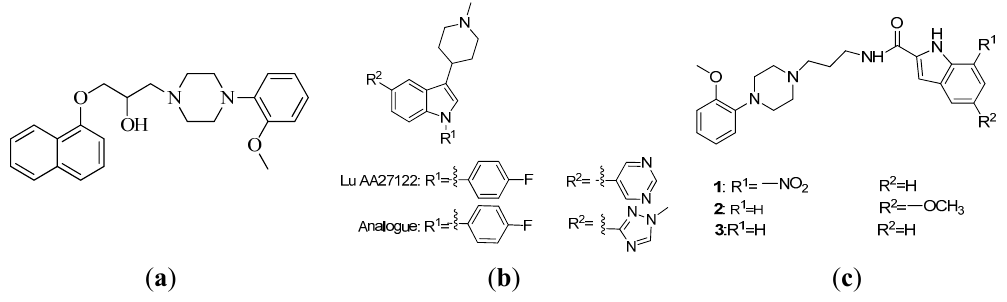
Figure 1. Chemical structures of naftopidil ( a ); Lu AA27122 and its analogue ( b ); and the title compounds 1 , 2 and 3 ( c ).